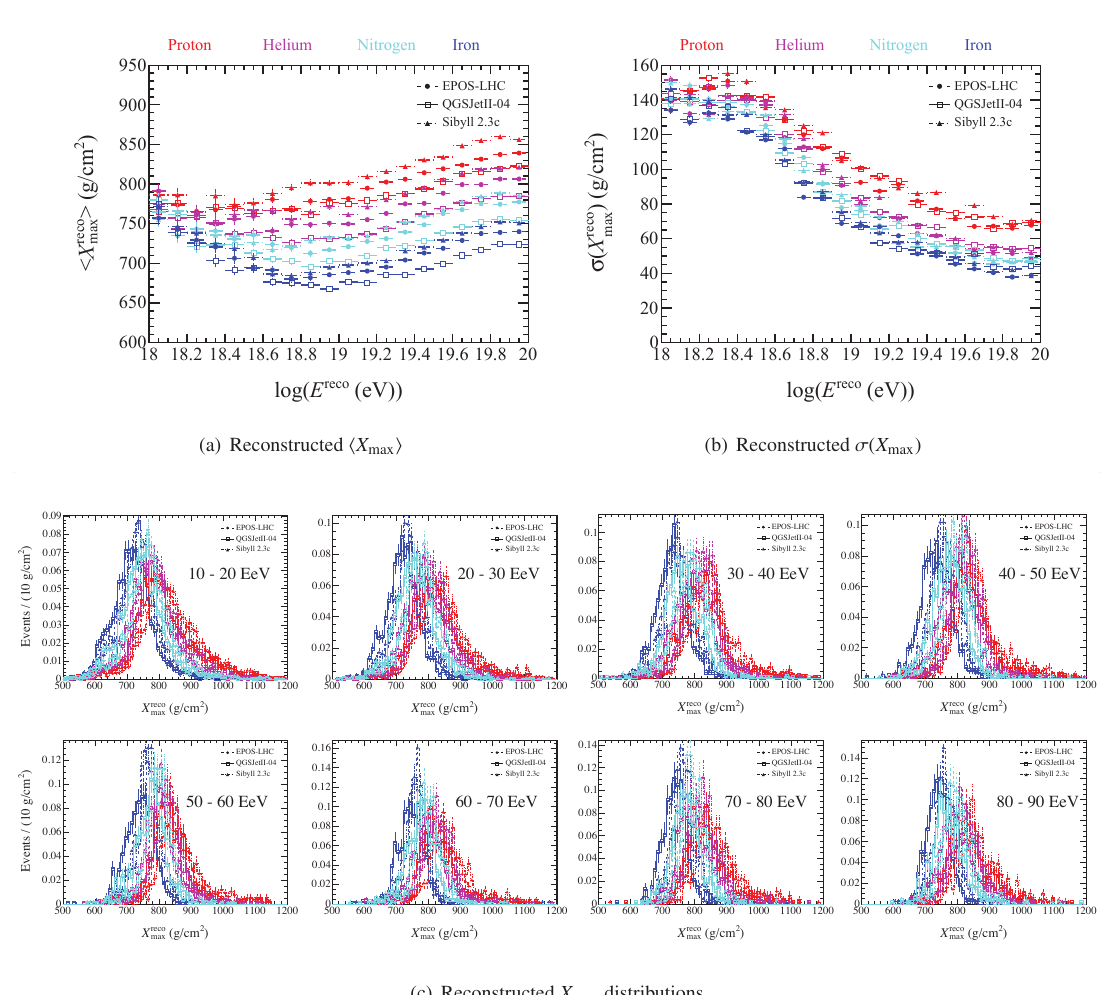
Figure 3. Reconstruction bias on (a) (cid:6) X max (cid:7) and (b) σ ( X max ) of four primaries (proton, helium, nitrogen and iron) with three interaction models (EPOS-LHC, QGSJetII-04, Sibyll 2.3c) reconstructed by the neural network first-guess estimation. (c) Their reconstructed X max distributions in each energy